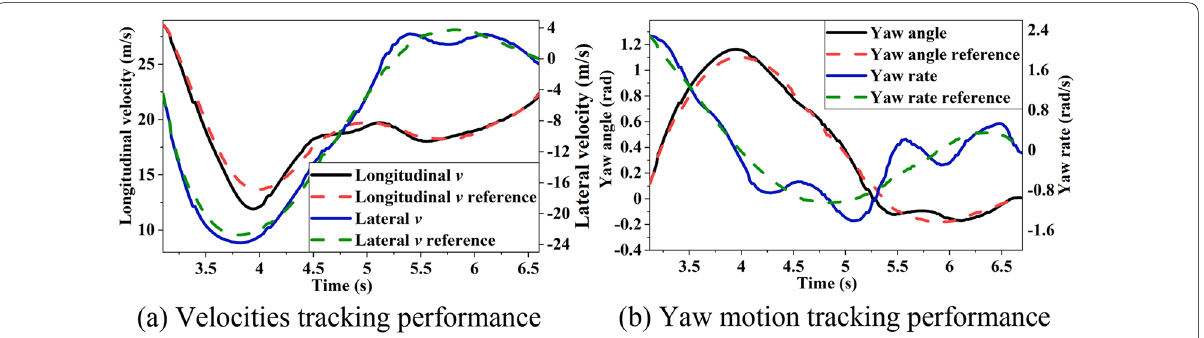
Figure 12 Velocities and yaw motion tracking results of